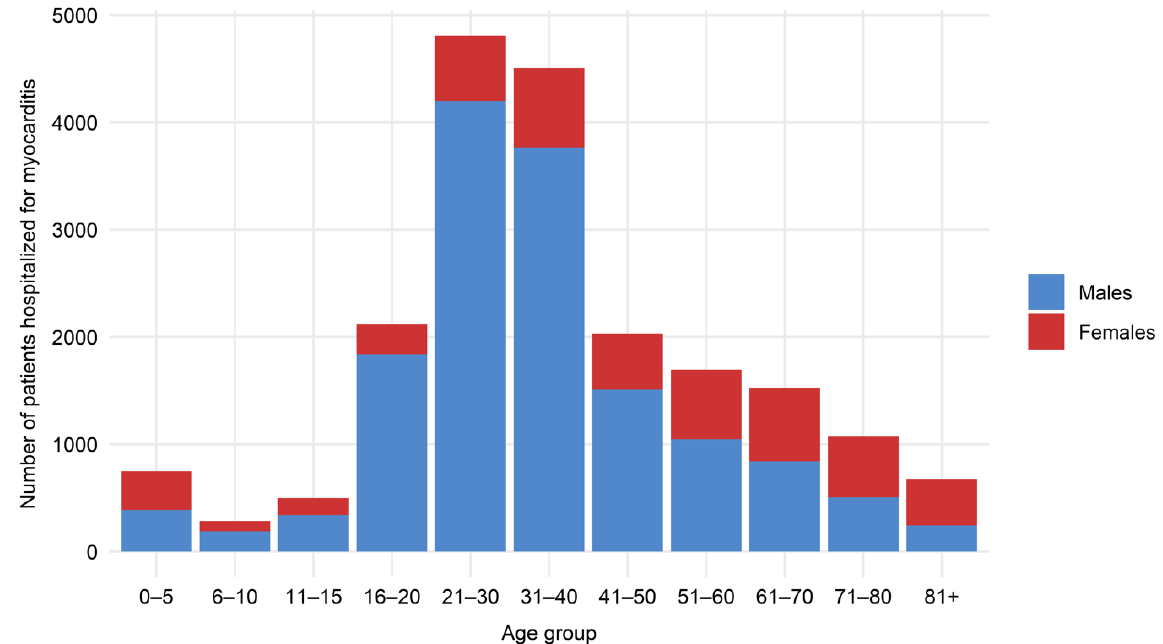
Figure 1. Age and gender distribution of all patients hospitalized for myocarditis in Poland in years 2011–2019. Red— females; blue—males.